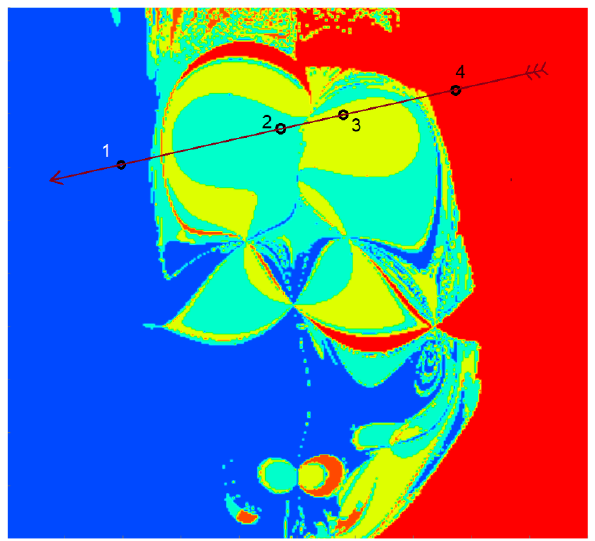
Figure 10. Figure 10. “Portrait” of the roots of the system of Equation (2), obtained by the Leven- berg − Marquardt method.